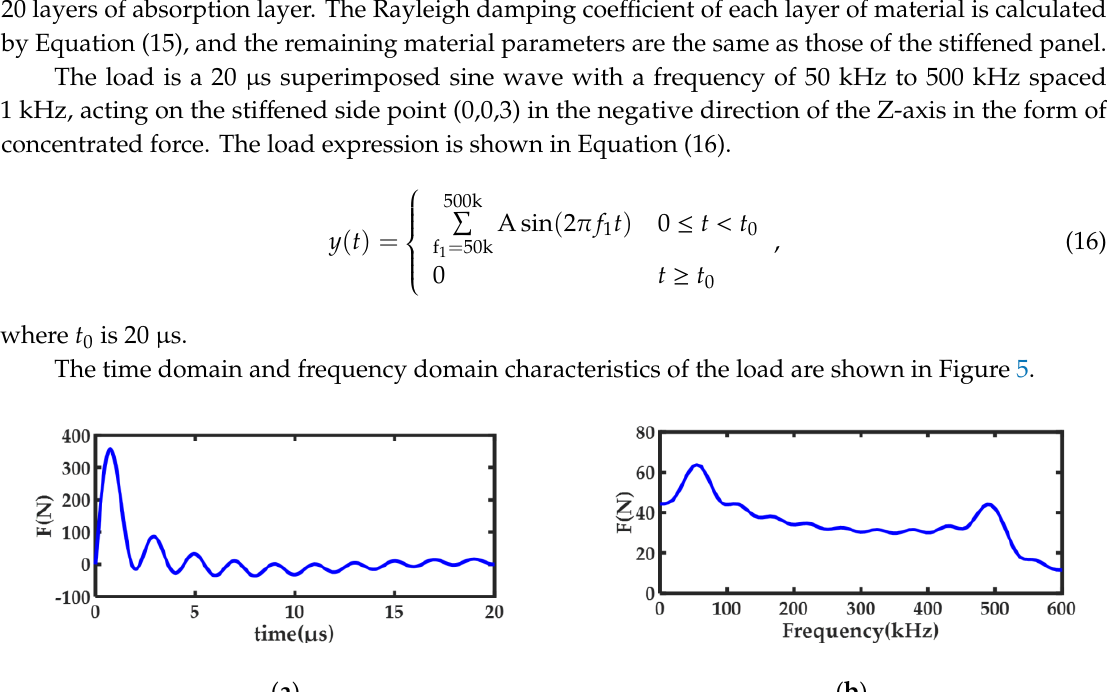
( b ) Figure 6. Three-dimensional finite element simulation model: ( a ) stiffened panel; ( b ) flat panel. 3.2. Effect of Stiffeners on Lamb Wave Velocity and Signal Head. The time-domain waveform of the z-axis displacement obtained at each receiving point of 230 mm from the origin is shown in Figure 7. As can be seen from the figure, the arrival time of the first trough of point 1 to 7 is about 42.2 μs, and the calculated wave velocity is 5.45 km/s. The first w ave trough of the Lamb wave after the same number of stiffeners is roughly equal. The first wave trough of the Lamb wave passing through the two stiffeners is significantly higher than passing three stiffeners, which is also applicable to the first wave crest. It can be seen that the number of stiffeners has almost no effect on the Lamb wave velocity. The more stiffeners the signal passes through, the lower the first crest and trough of the signal is.